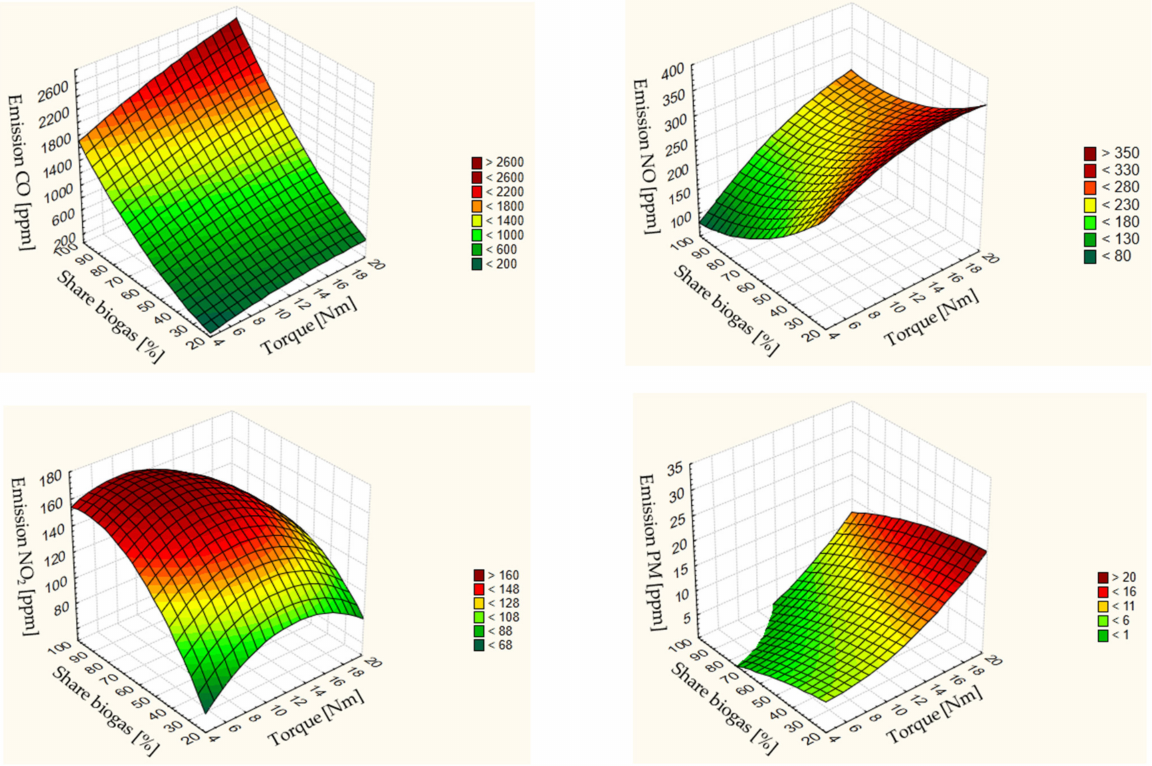
Figure 10. Emission of CO, NO, NO 2 , and PM in the mixture of RME and BG at variable